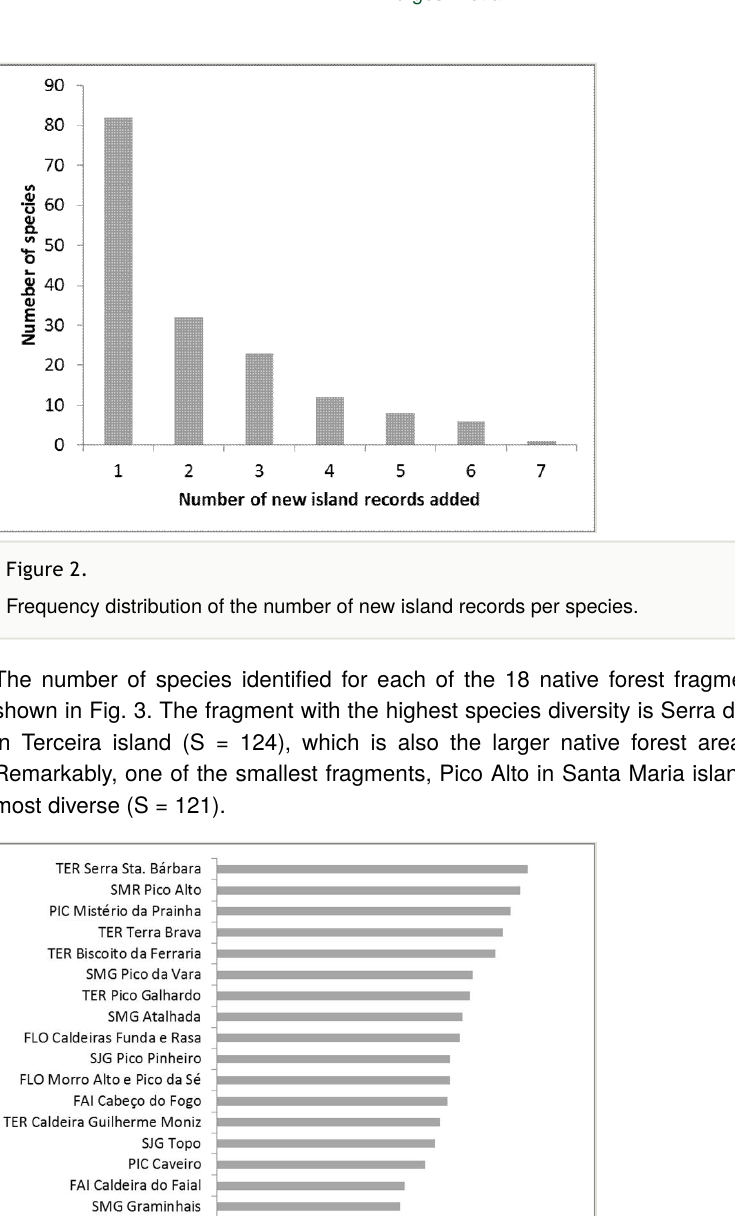
Number of species per native forest fragments. Island codes as in Table